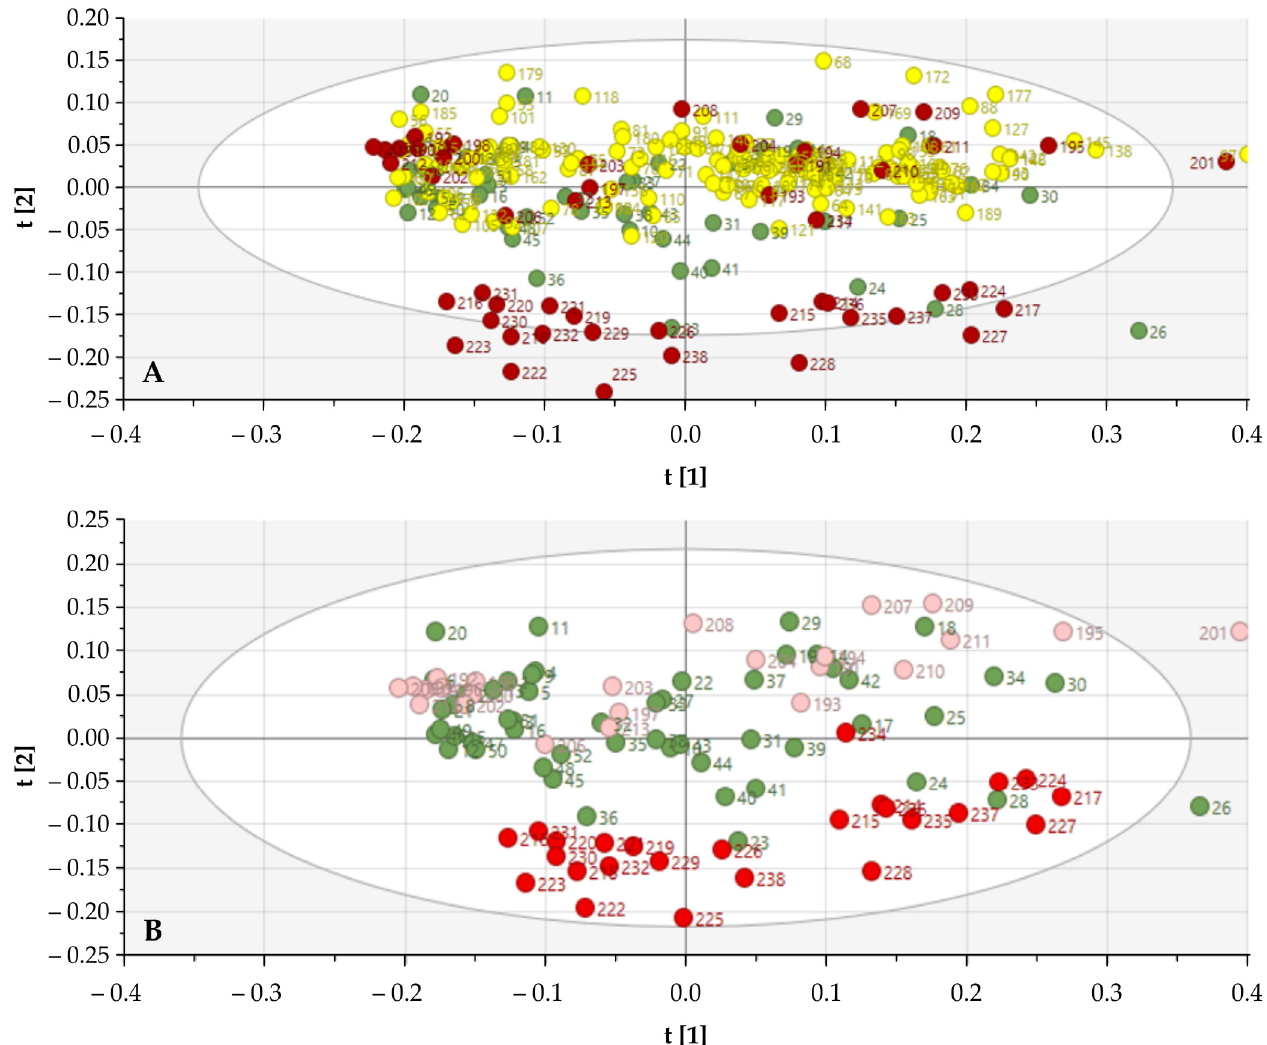
Figure 5. Score plots of NIR spectra following neuraminidase treatment for differentiation of salivary gland specimens. The effect of narrowing to the region of interest in the NIR spectra (according to the wavelengths mentioned in Figure 3) is illustrated. A clear difference can be noted in comparison to the previous score plot (Figure 2). ( A ) Score plot of all tissue samples according to the oncological classification (control (green), benign (yellow), and malignant (red)). ( B ) Score plots according to malignant histological classification (control (green); acinic cell carcinoma, mammary analogue salivary carcinoma, and adenoid cystic carcinoma (light red); and epithelial myoepithelial carcinoma, mucoepidermoid carcinoma, and salivary duct carcinoma (dark red)).